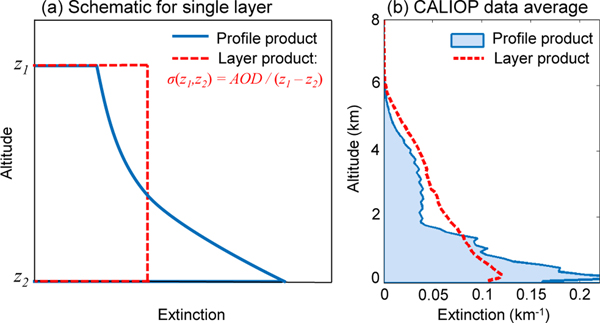
(a) Schematic example of aerosol extinction profile for an individual layer reported by the profile product (blue) and by the layer product (red dashed), where mean aerosol extinction is computed from the layer AOD divided by the geometric depth (Δz). (b) Seasonal average of CALIOP aerosol extinction computed by the profile product (blue, filled) and by the layer product (red dashed) for June–August 2007 at night over the central Atlantic Ocean region (Table A1).